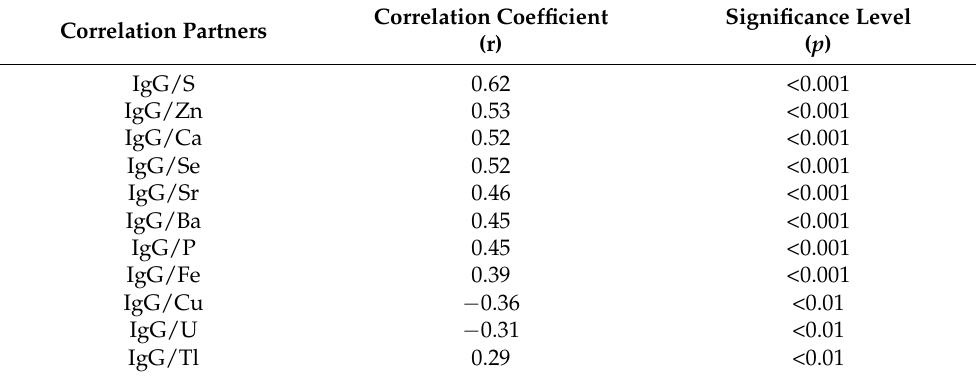
Table 1. Correlation coefficients and significance levels between IgG content and other mineral content in alpaca colostrum from 20 alpaca mares during four days after parturition ( n =